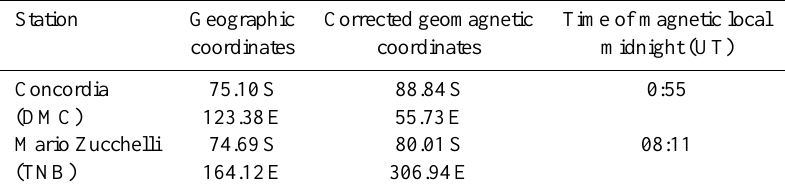
Table 1. Coordinates of the recording stations.